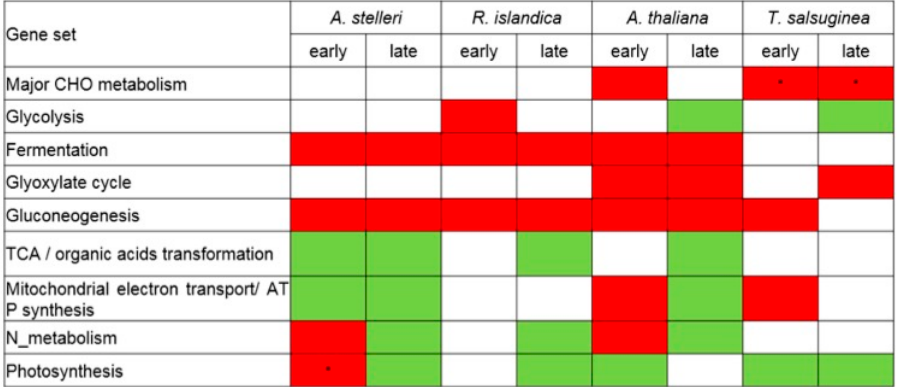
Figure 4. Reconfiguration of energy metabolisms in response to low-oxygen stress at the level of gene set. The regulation of energy metabolism-related gene sets was analyzed from the GSEA results of A. thaliana , A. stelleri , R. islandica , or T. salsuginea . The red box represents upregulation and green box represents downregulation. Asterisks indicate normalized levels compared to the gene expression of A. thaliana under normal conditions.